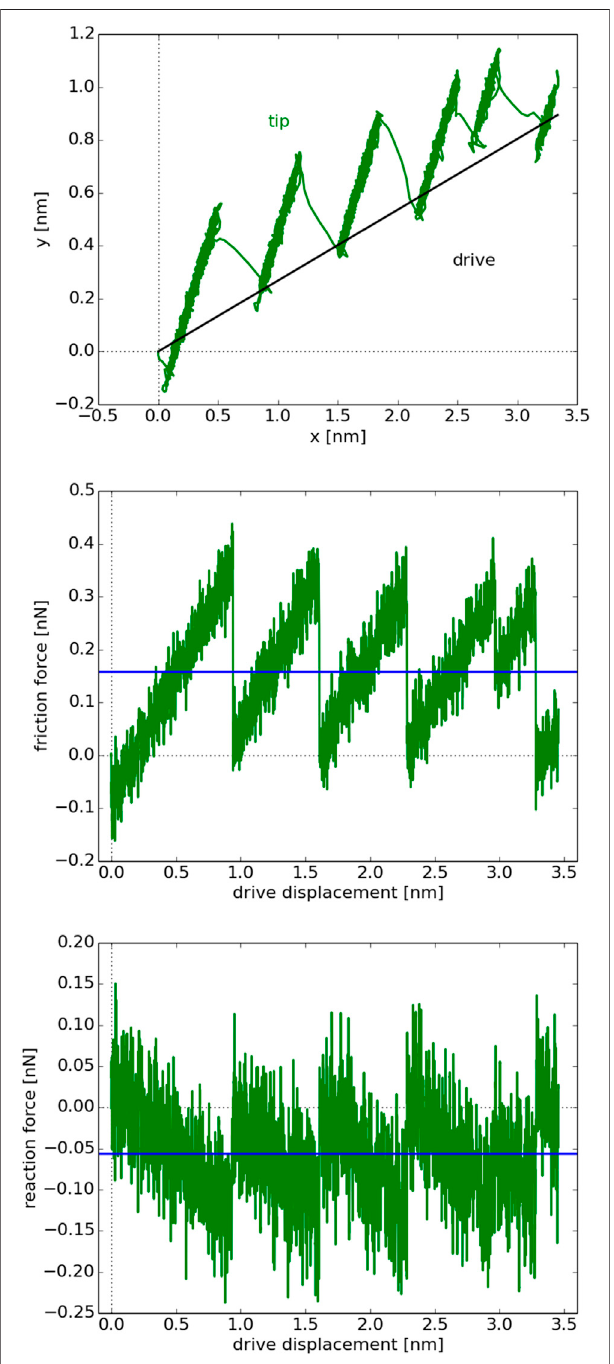
FIGURE 1 | Stick-slip movement of the AFM-tip at RT of 300 K along an incommensurate sliding path Φ (cid:2) 15 deg for an η set accordingly, when U 0 is keptconstantand k c isadjusted,recall Eqs3 , 14 .Thetrajectoriesofdrive(black) and AFM-tip (green) are shown in the top panel , whereas the friction and reaction forces(green) at each position ofthe drive are given in the middleand bottom panels together with their means (blue) over the entire sliding path.